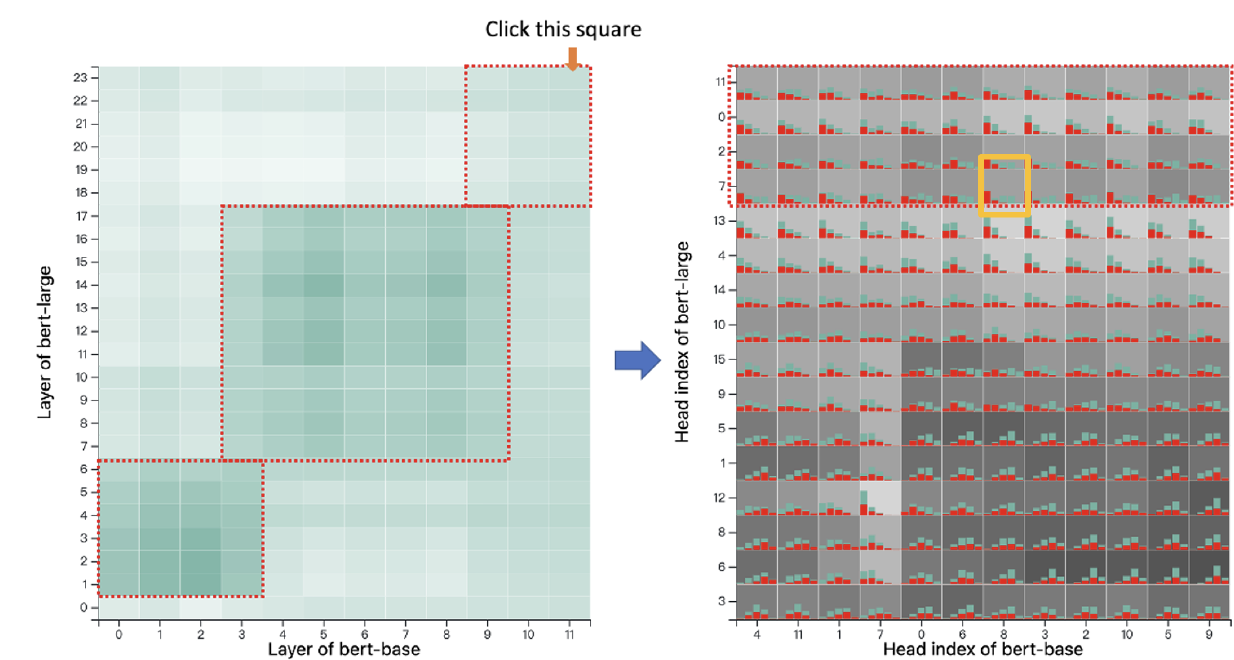
Figure 15. The ( Left ) figure shows three dark green blocks (dotted rectangles). This indicated that three layer groups in each model and a group and the corresponding group in the other model extract similar linguistic information. ( Right ) After clicking the square (orange arrow), the user observes that the head similarity graph of this layer combination has red bar charts that are